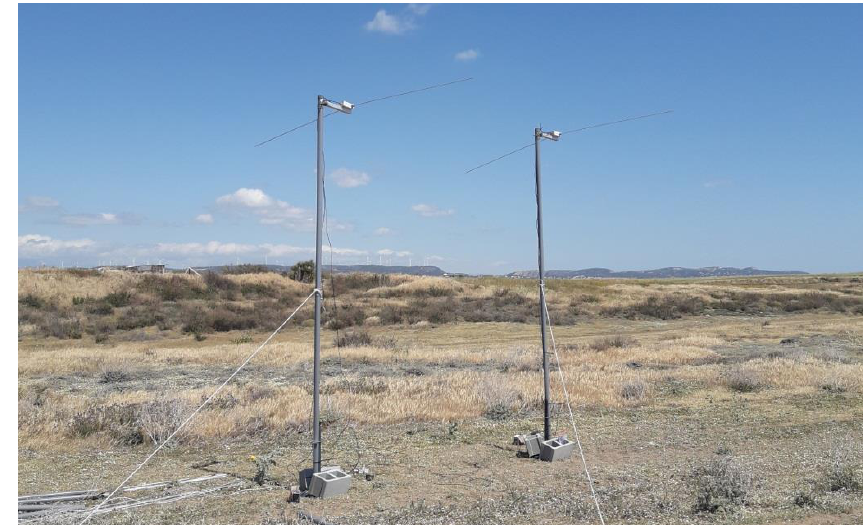
Figure 10. The active phased array under test.